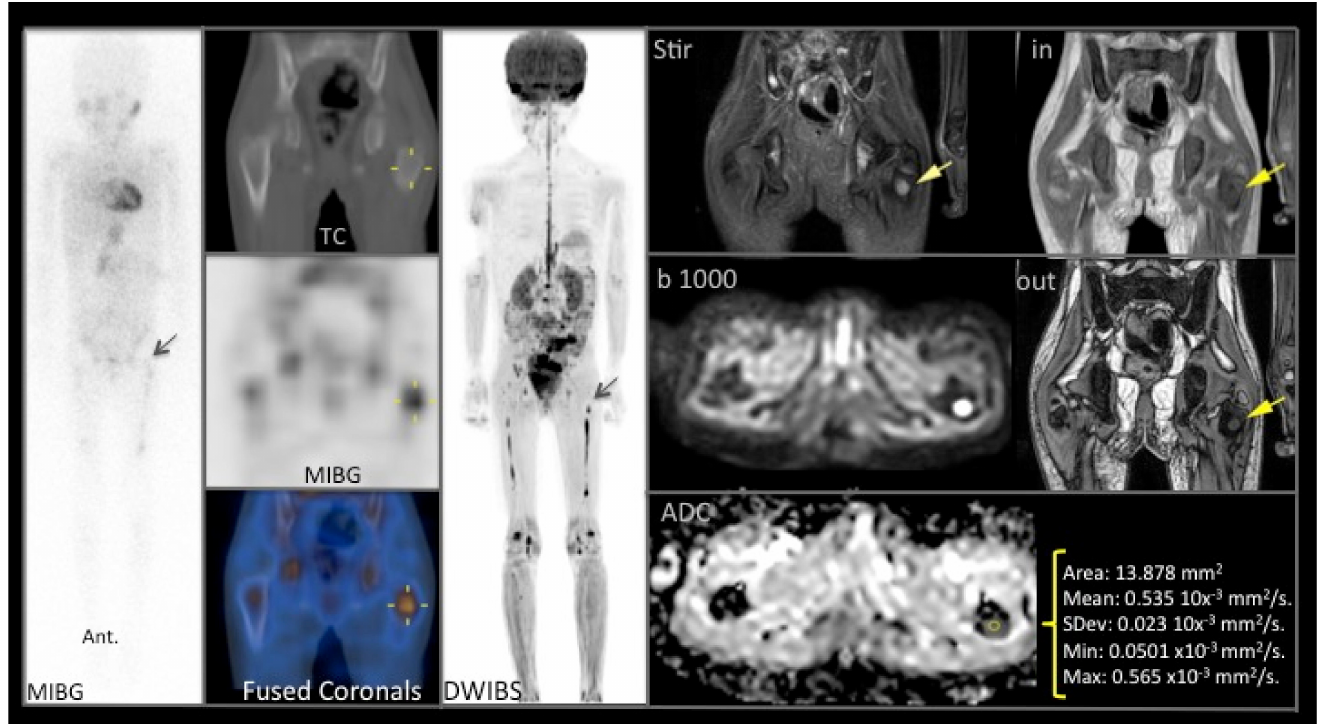
Figure 3. Example of a good correlation between proximal left femoral metaphysis 123 I-Metaiodobenzylguanidine (MIBG) bone uptake (left column) and MRI/DW (middle and right panels) for patient #13 (Table 1), showing T1 hypointense, STIR T2 hyperintense focal bone lesion with restricted diffusion (b 1000), and low ADC (<1.01)